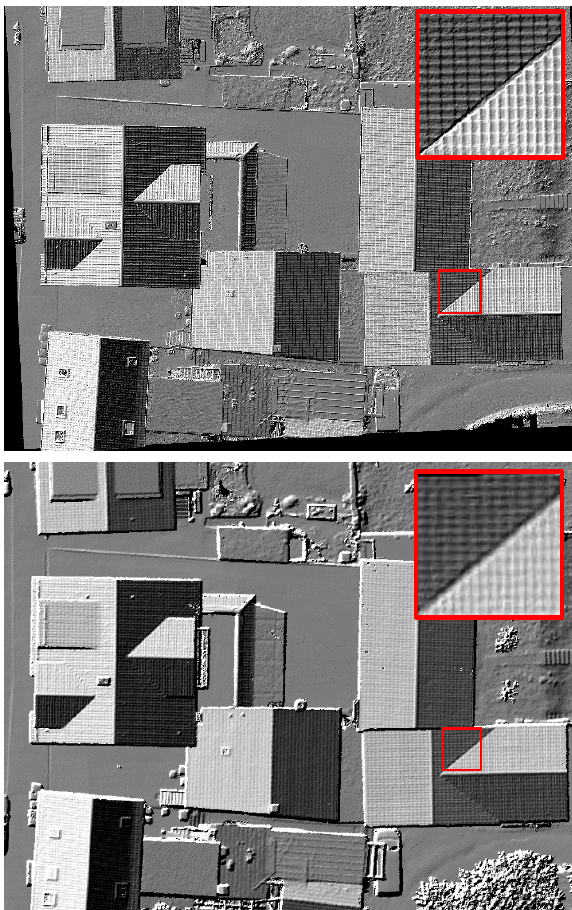
Figure 7. Shaded DEM from dense image matching (top, 1 cm grid width) and LiDAR DEM (bottom, 5 cm grid width). The marked region is zoomed-in.